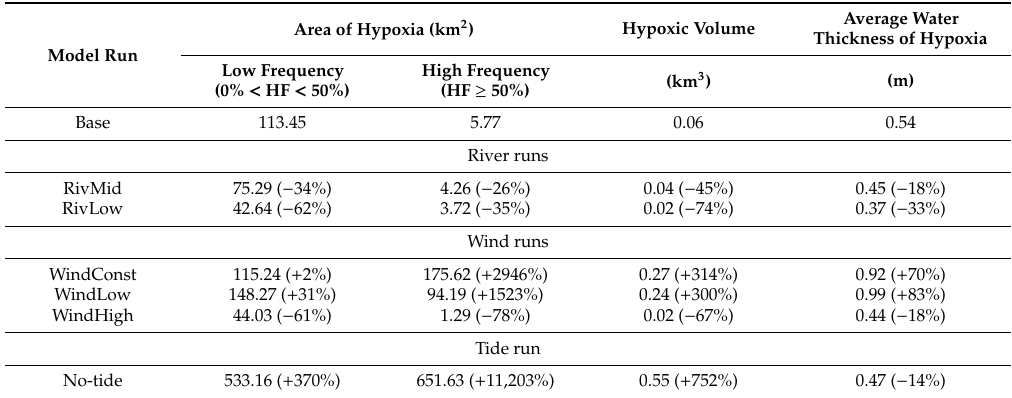
Table 4. Hypoxic areas, volumes, and water thicknesses simulated by di ff erent model runs.